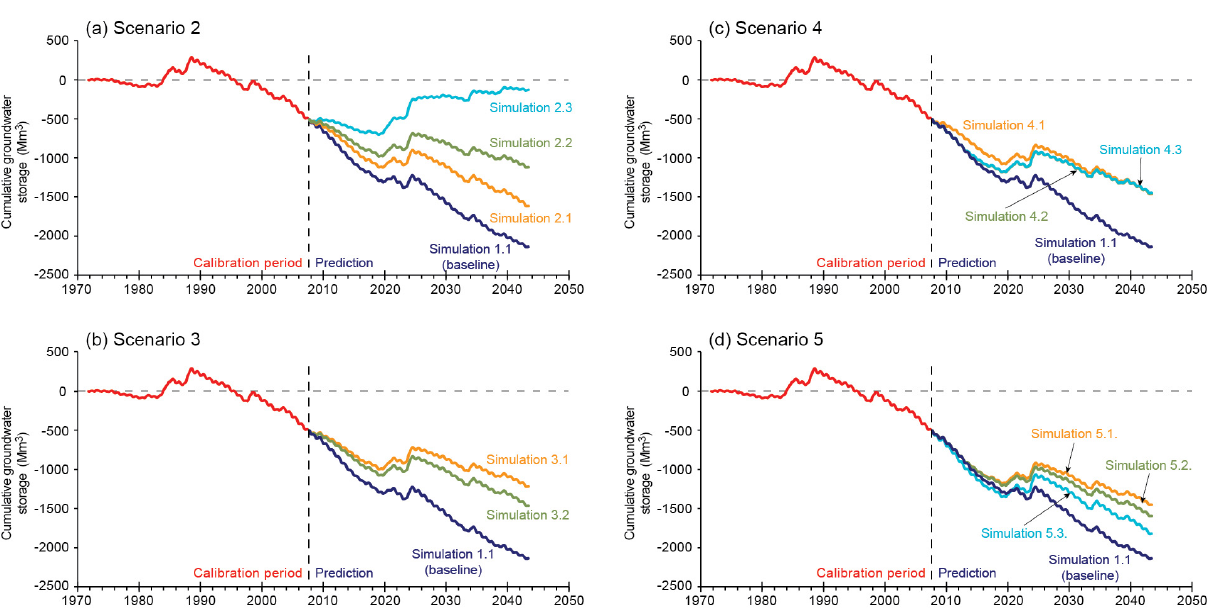
Figure 5. Cumulative aquifer storage volume for different scenarios. The reference (null) volume corresponds to 1974. ( a ) Scenario 2; ( b ) Scenario 3; ( c ) Scenario 4; ( d ) Scenario